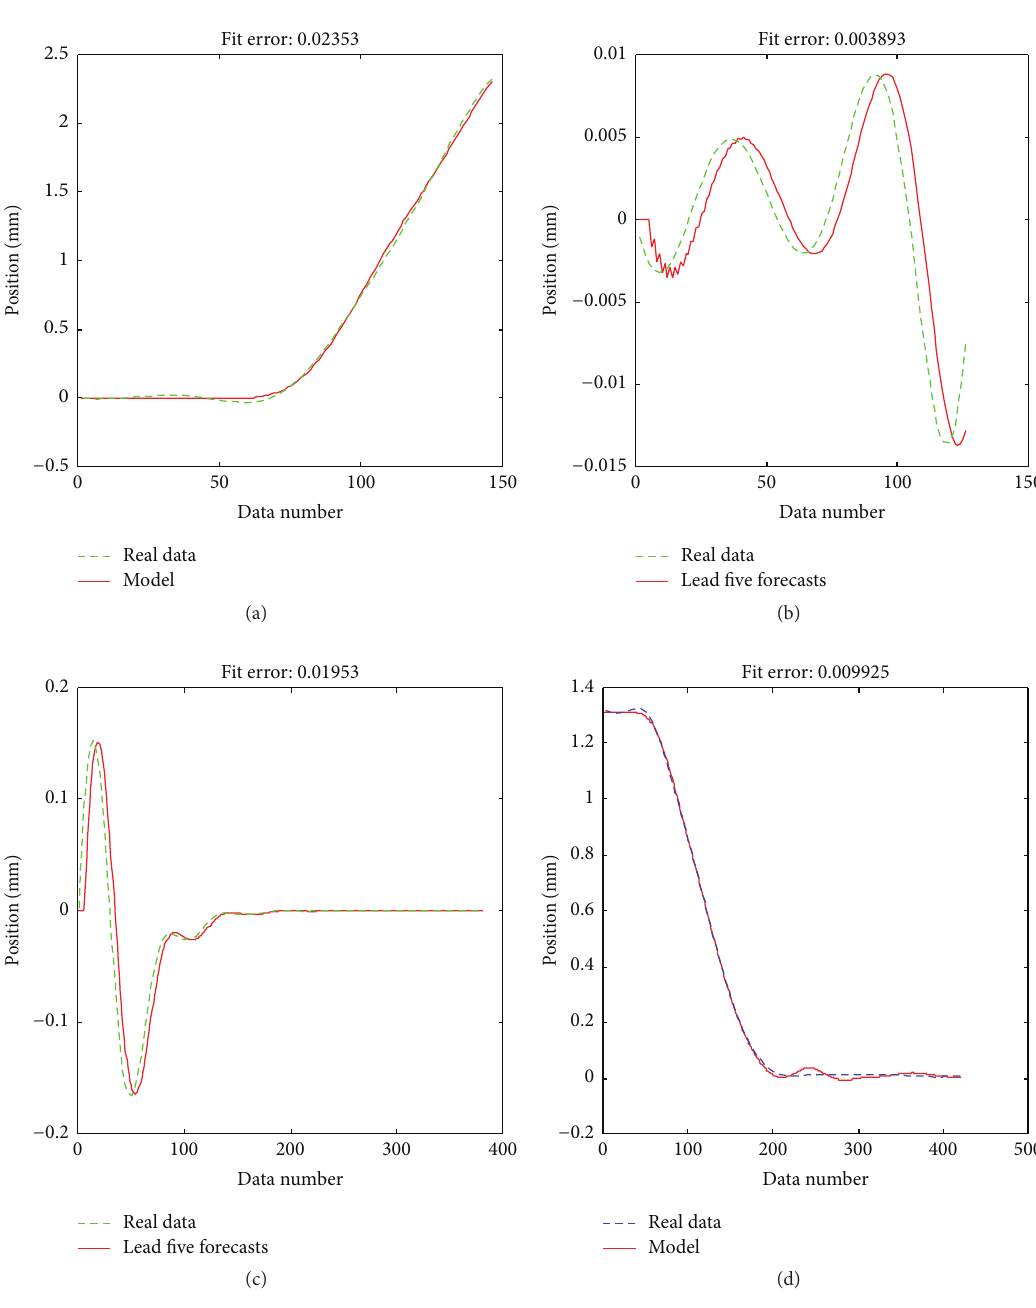
dynamic response generated by identified model.